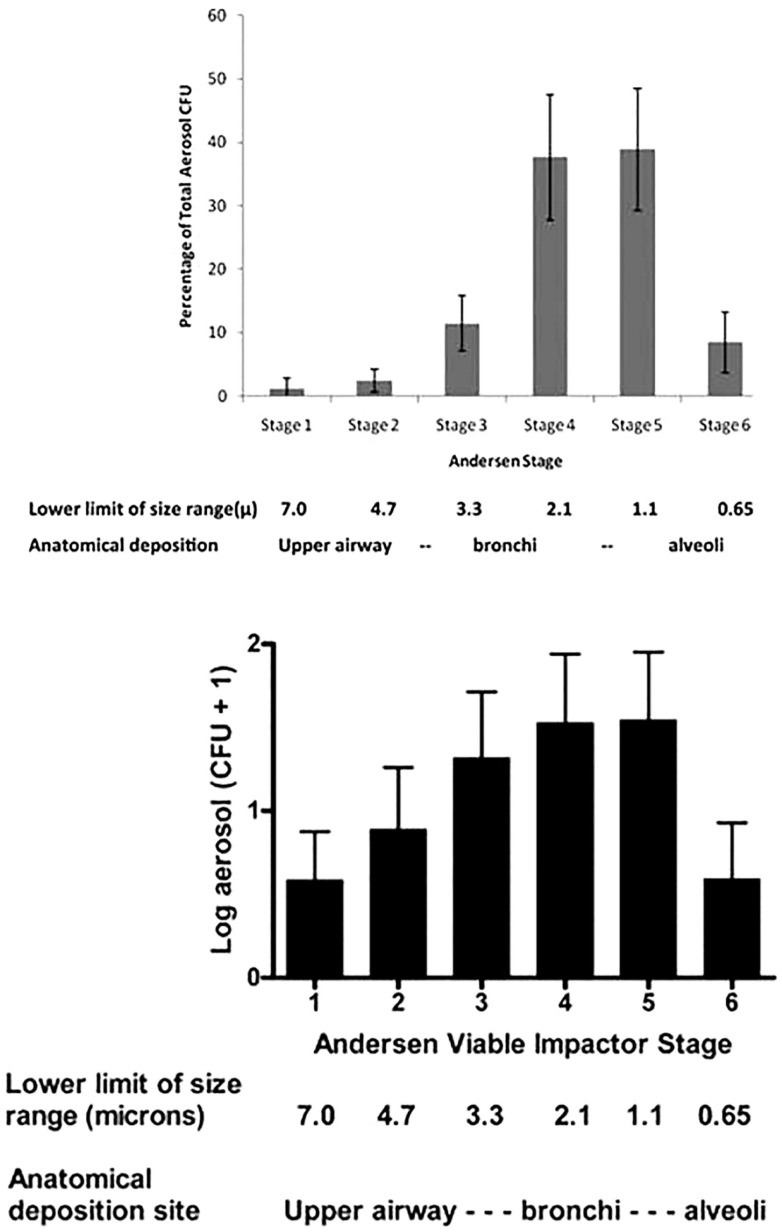
Particle size distributions of cough aerosols from patients with active pulmonary TB [top panel; from Ref. (67)] and from cystic fibrosis patients with chronic P. aeruginosa infections [bottom panel; from Ref. (60)].